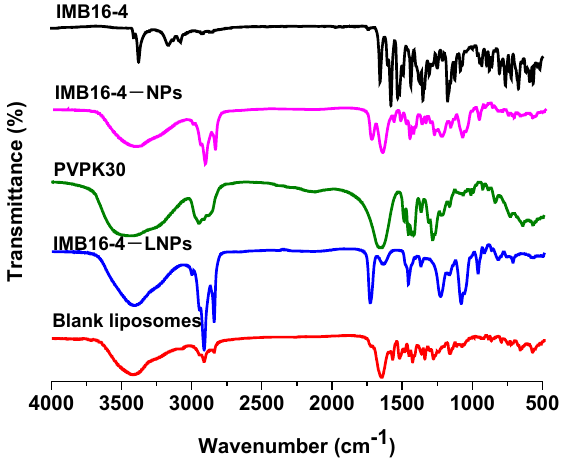
Figure 2. FTIR spectra of blank liposomes, IMB16-4 − LNPs, IMB16-4 − NPs, and IMB16-4 solid powder with a frequency range of 400 to 4000 cm −1 .